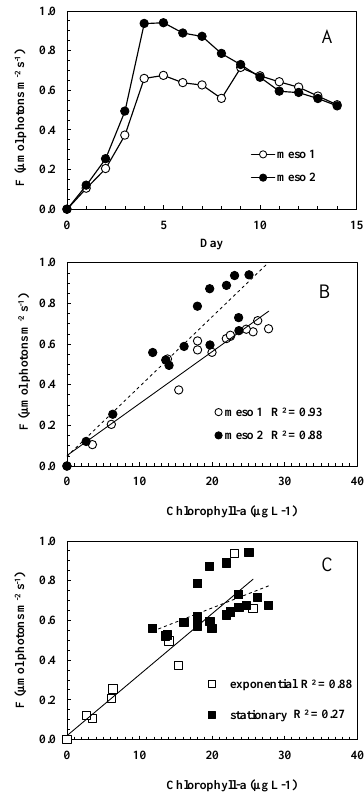
Figure 5. (a–c) Fluorescence emission. (a) Daily development of the fluorescence emission near 682nm ( F , µmolphotonsm − 2 s − 1 ) calculated from reflectance spectra, (b) linear regression of fluo- rescence ( F , µmolphotonsm − 2 s − 1 ) on chlorophyll a (µgL − 1 ) for both mesocosms separately, and (c) for both exponential and sta- tionary growth